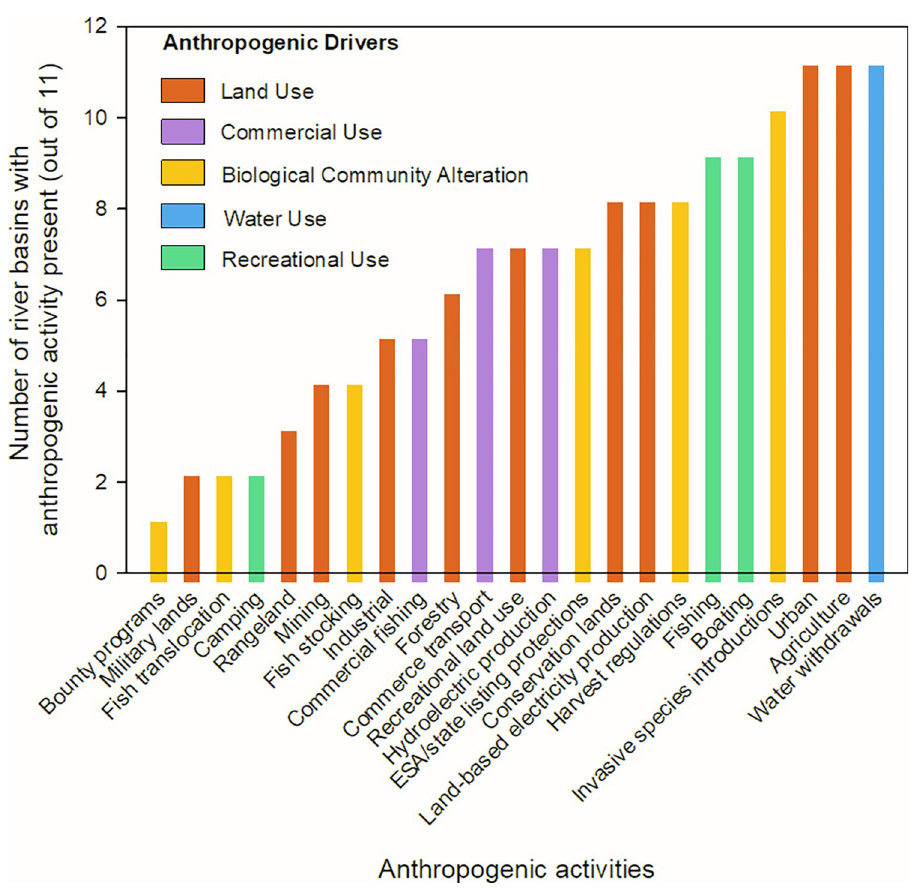
Fig 2. The results of a query to scientists from the Canadian, Colorado, Columbia, Hudson, Illinois, Ohio, Missouri, Red, Tallapoosa, Upper Mississippi, and Wabash Rivers, U.S to identify anthropogenic activities that affect large-river fishes in the river systems they represent. Anthropogenic activities were classified into five driver